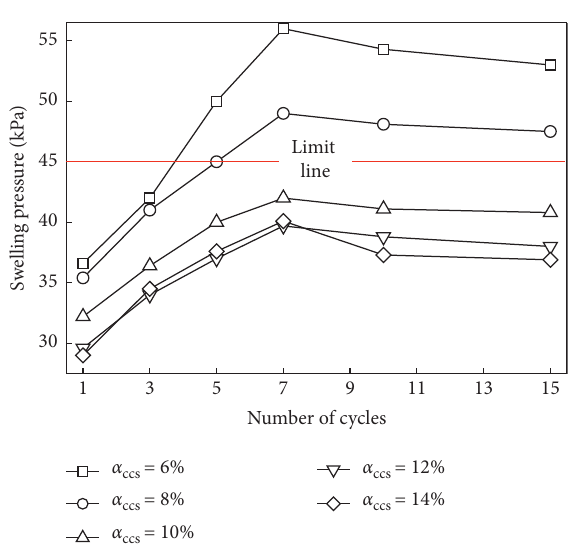
Figure 2: Swelling pressure during the drying-wetting process.